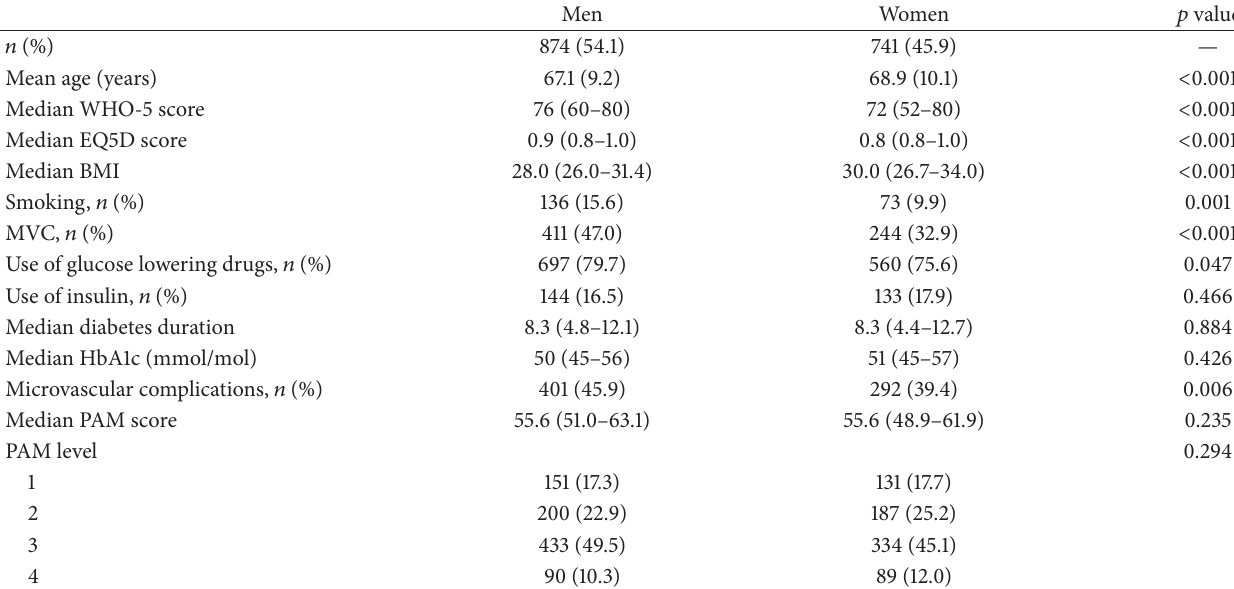
Table 1: Patient